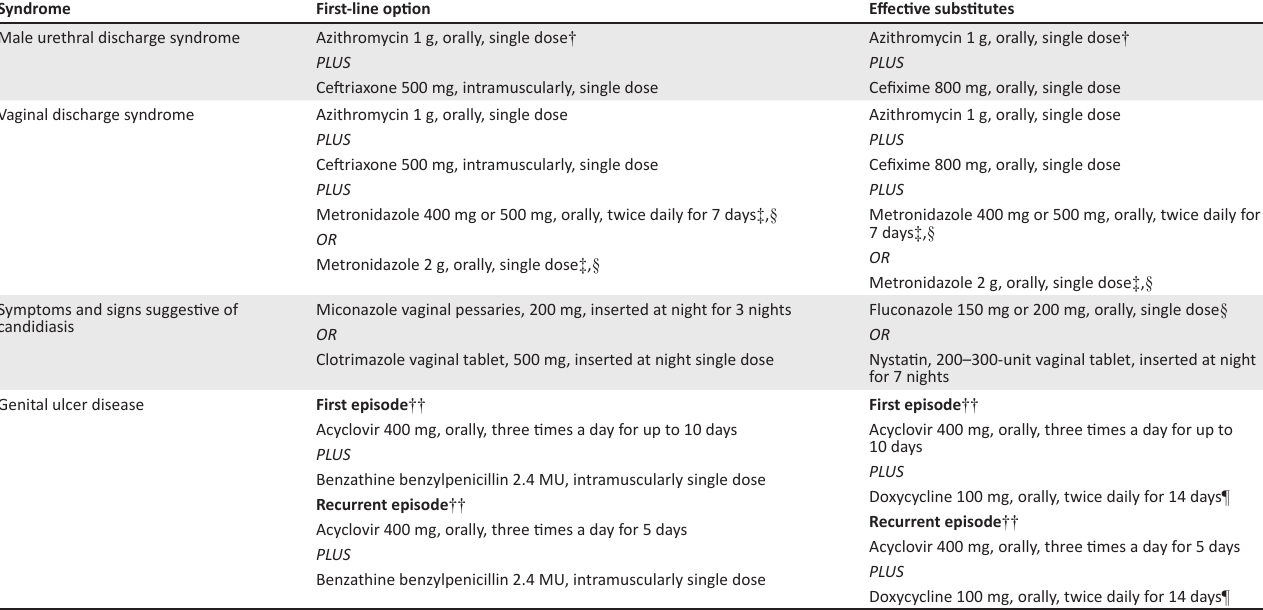
TABLE 3: Recommended first-line antimicrobial treatment regimens for sexually transmitted infection syndromic management.